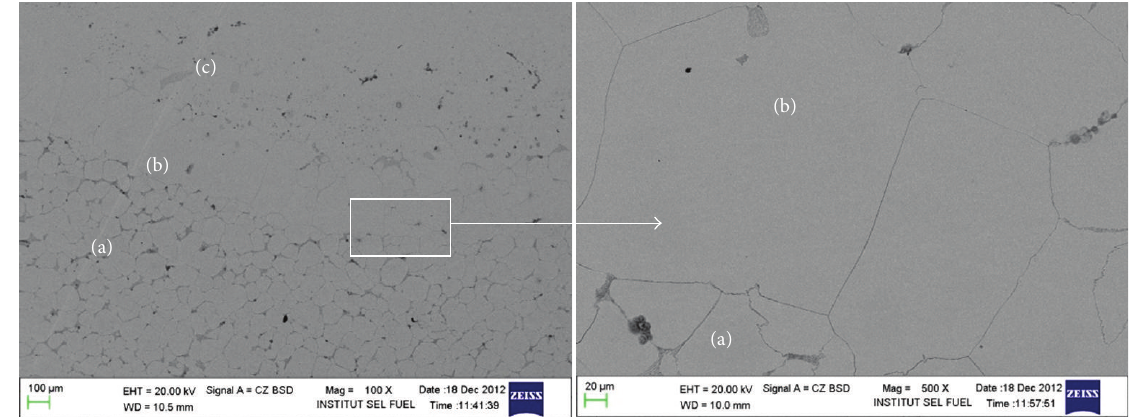
Figure 8: Image of microstructures of (a) AISI D2, (b) diffusion zone, and (c) AISI 304.